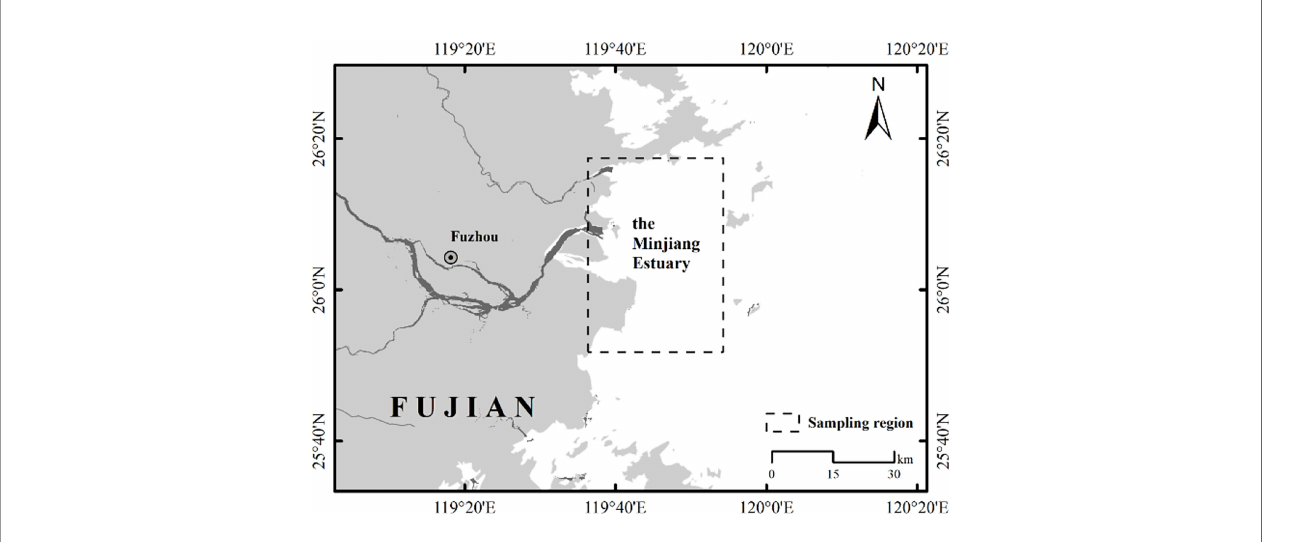
FIGURE 1 | The sketch map of the Minjiang